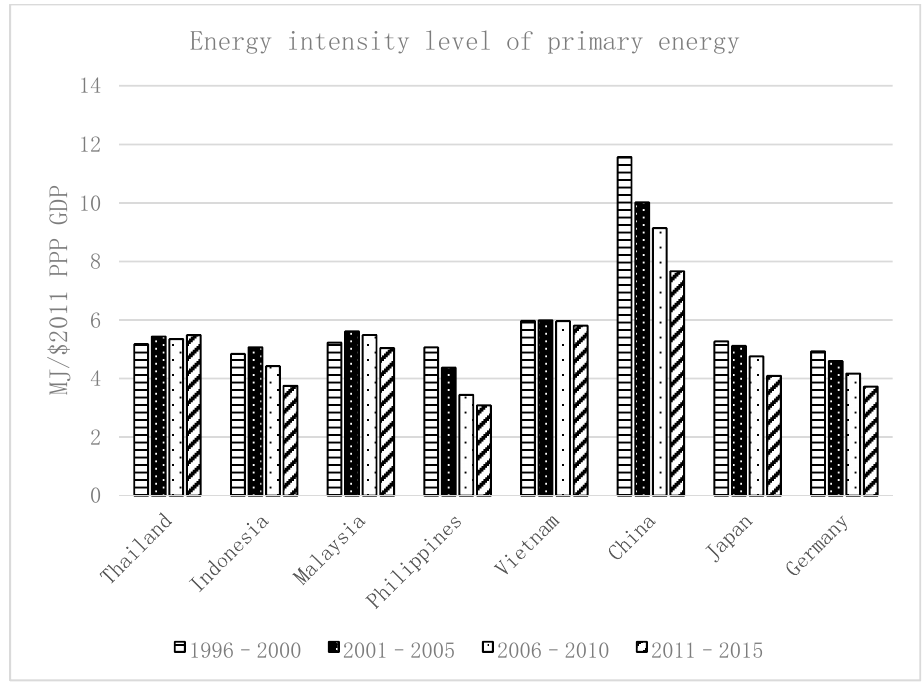
Figure 5. Energy intensity level of primary energy source (primary energy use per unit of Gross Domestic Product: data are from the World Development Indicators Database).